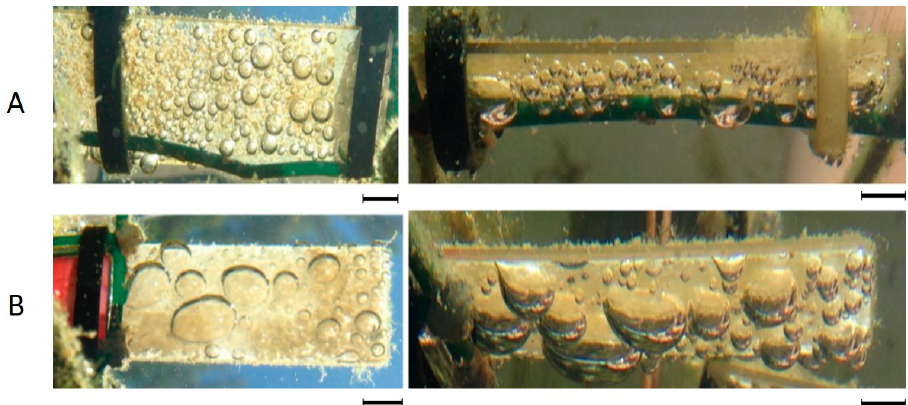
Figure 6. Glass control ( A ) and superhydrophobic (SH) sample ( B ) after 10 days of immersion. On the